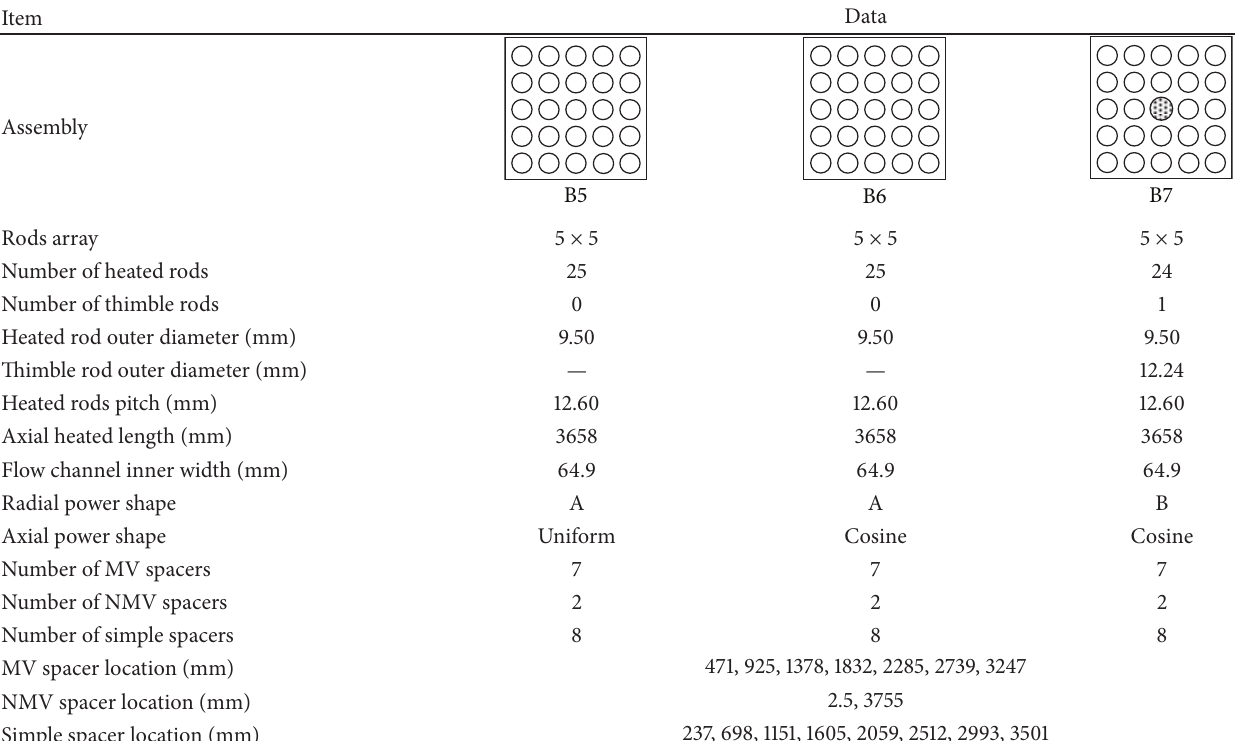
Table 4: Geometry and power shape for bundle test assemblies for void distribution